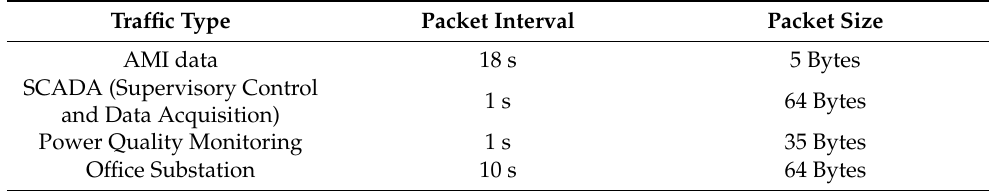
Table 2. Smart grid application.